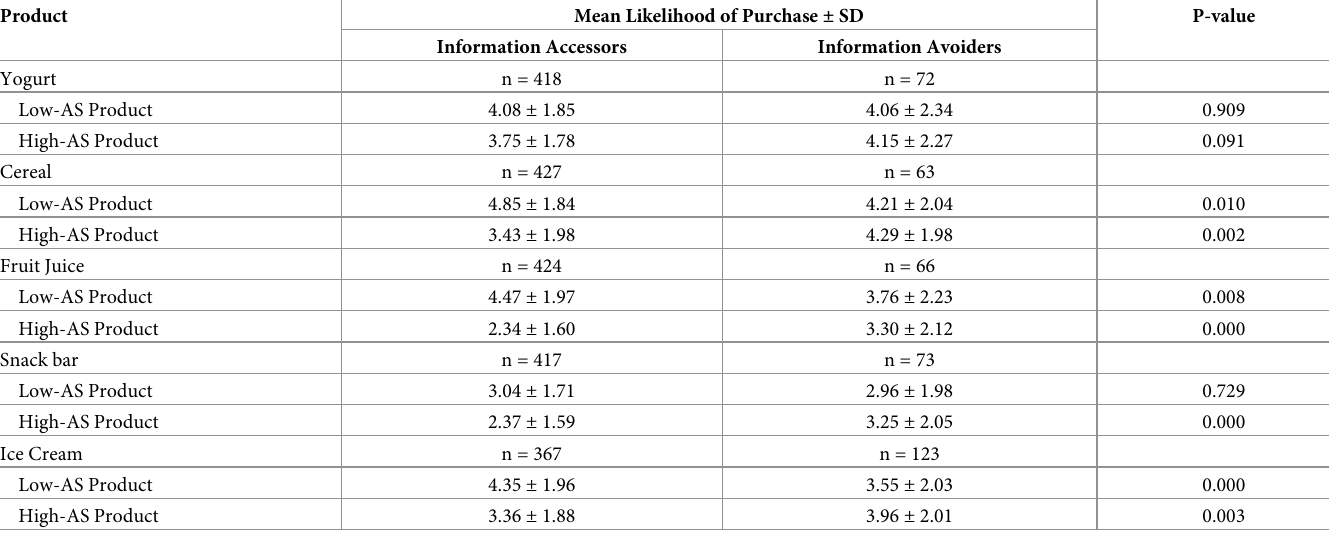
Table 3. One-Way ANOVA tests comparing likelihood of purchase ratings between information accessors and information avoiders by product. Product Mean Likelihood of Purchase ±